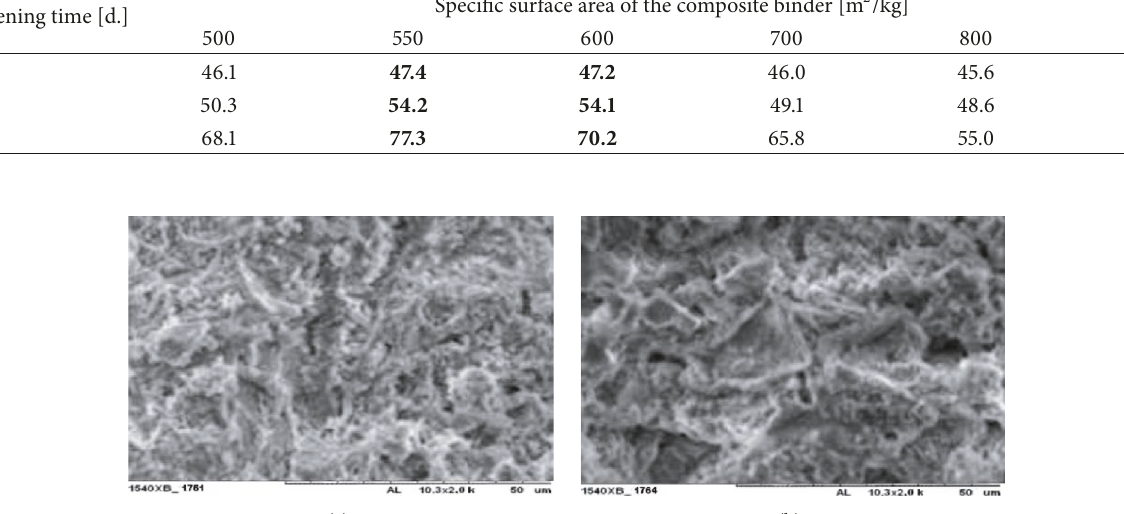
and are used as filler at the nano- and microlevels. In con- junction with the larger particles of the mineral component, denser filling of intergranular spaces is noted in concrete cement stone structure with reduction in number of pores and microcracks.